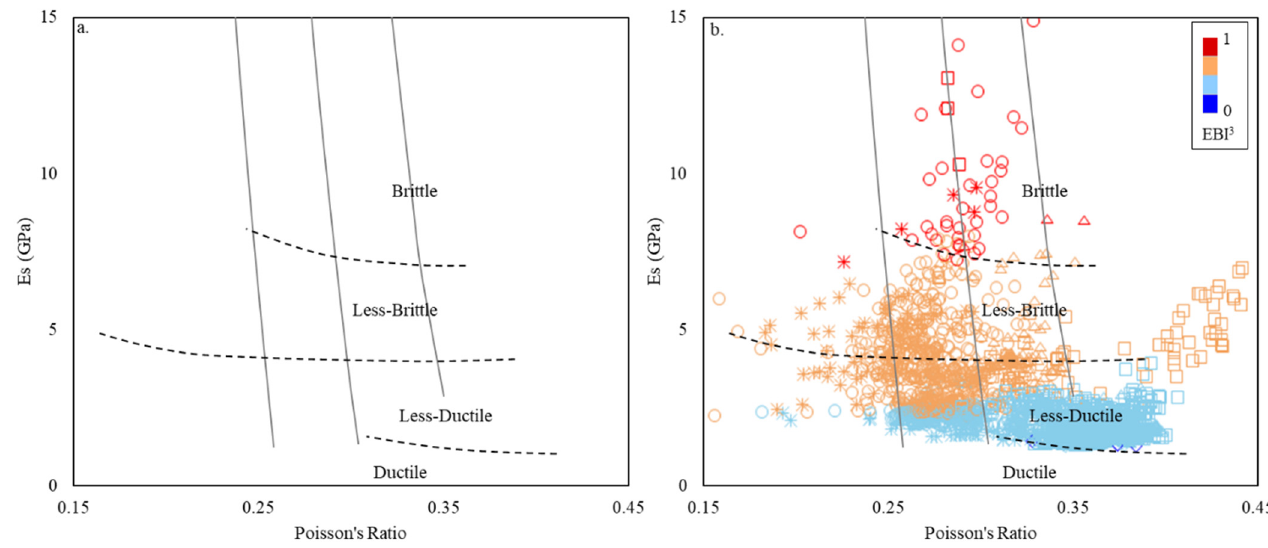
Figure 9. ( a ) Brittleness template (black dotted lines) based on the Drake caprock shale data points (adapted from Rahman et al. [87]). The studied well data points show a better match with the new template ( b ). The Perez and Marfurt [67]) brittleness curves (solid lines) are also displayed for com- parison.